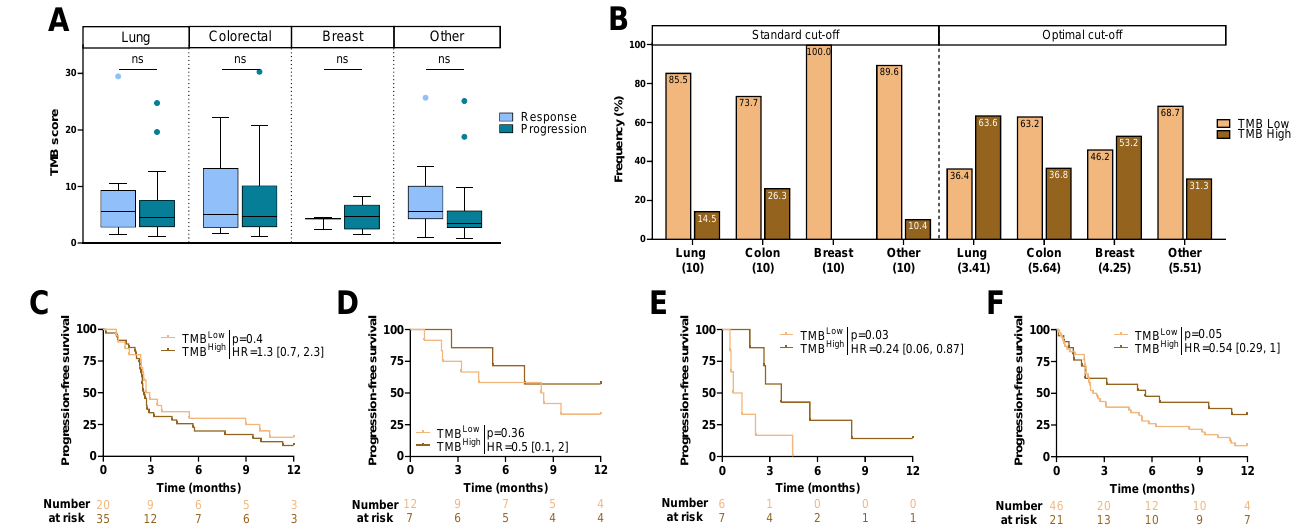
Figure 2. TMB score and outcome: ( A ) Boxplots showing TMB score according to RECIST criteria for each cancer. ( B ) Barplots representing frequency of TMB High and TMB Low patients dichotomized according to the standard cut-off and optimal cut-off for each cancer (cut-off in brackets). ( C – F ) Kaplan–Meier curves with patients stratified according to TMB status (optimal cut-off) for progression-free survival for ( C ) non-small-cell lung cancer, ( D ) colorectal cancer, ( E ) breast cancer, and ( F ) other cancers. ns: not